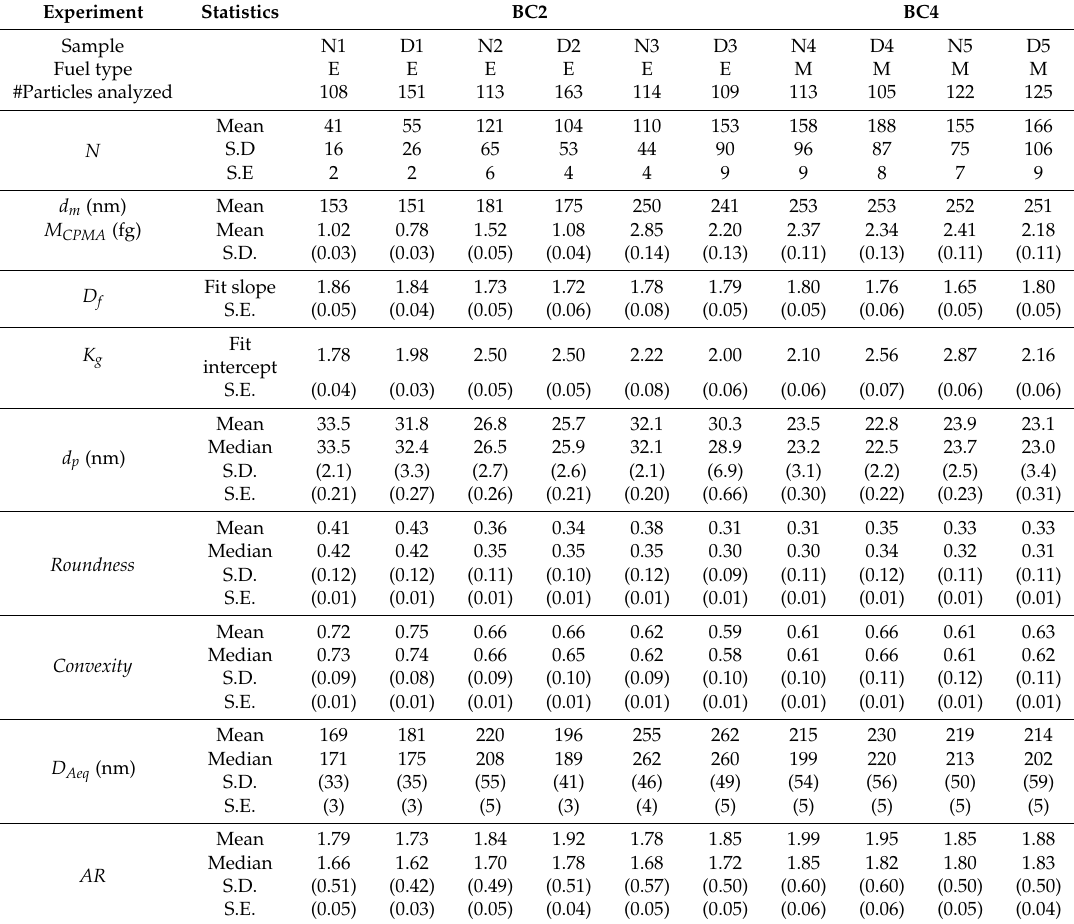
Table 1. Summary of physical and morphological parameters for the soot particles analyzed.